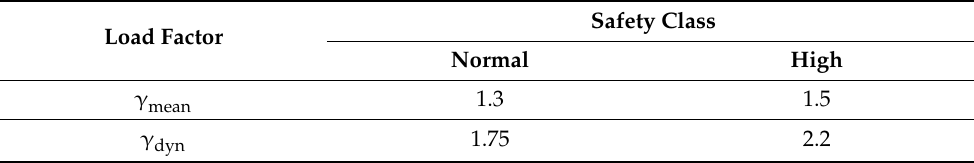
Table 2. Load factor requirements for the ULS (ultimate limit state)